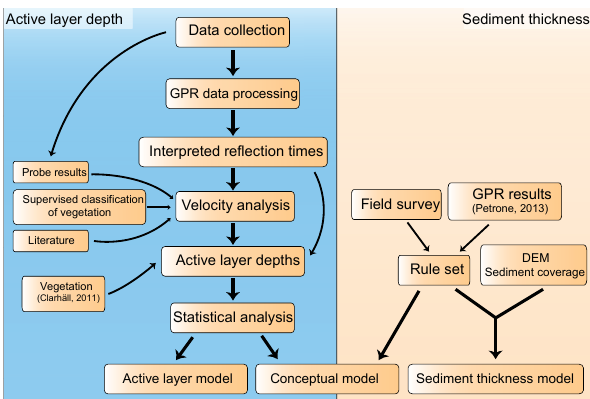
Figure 2. General work flow leading up to the completed models covering both active layer thickness and regolith